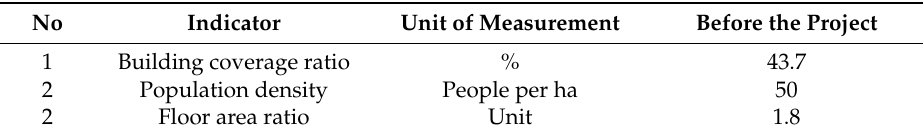
Table 5. Land e ffi ciency of the polycentric